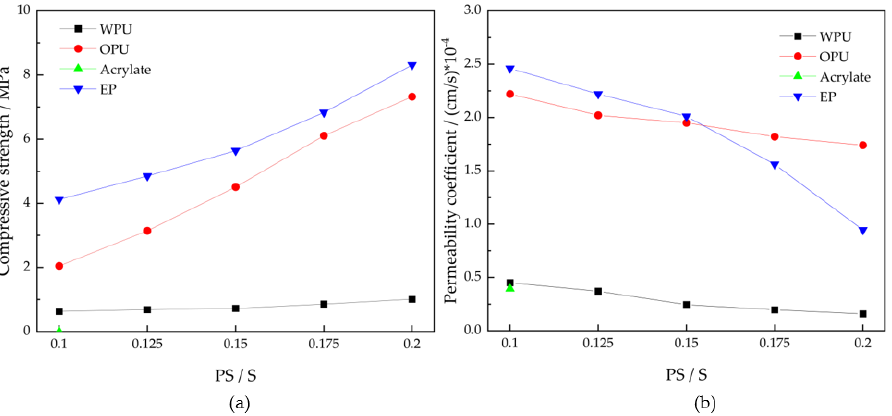
Figure 4. Chemical grouted sands performance change curve: ( a ) variation of compressive strength; ( b ) variation of permeability coefficient.